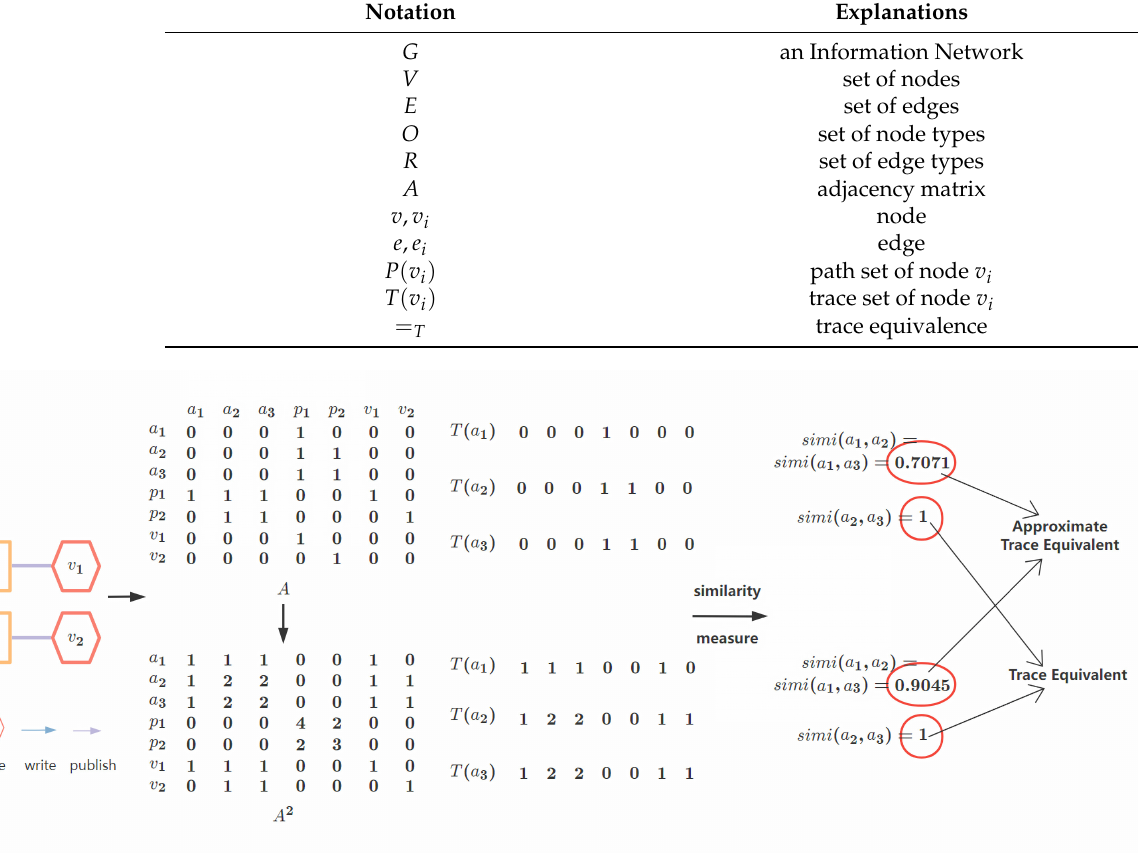
Figure 2. Illustration of computational methods of trace equivalence assisted by adjacency